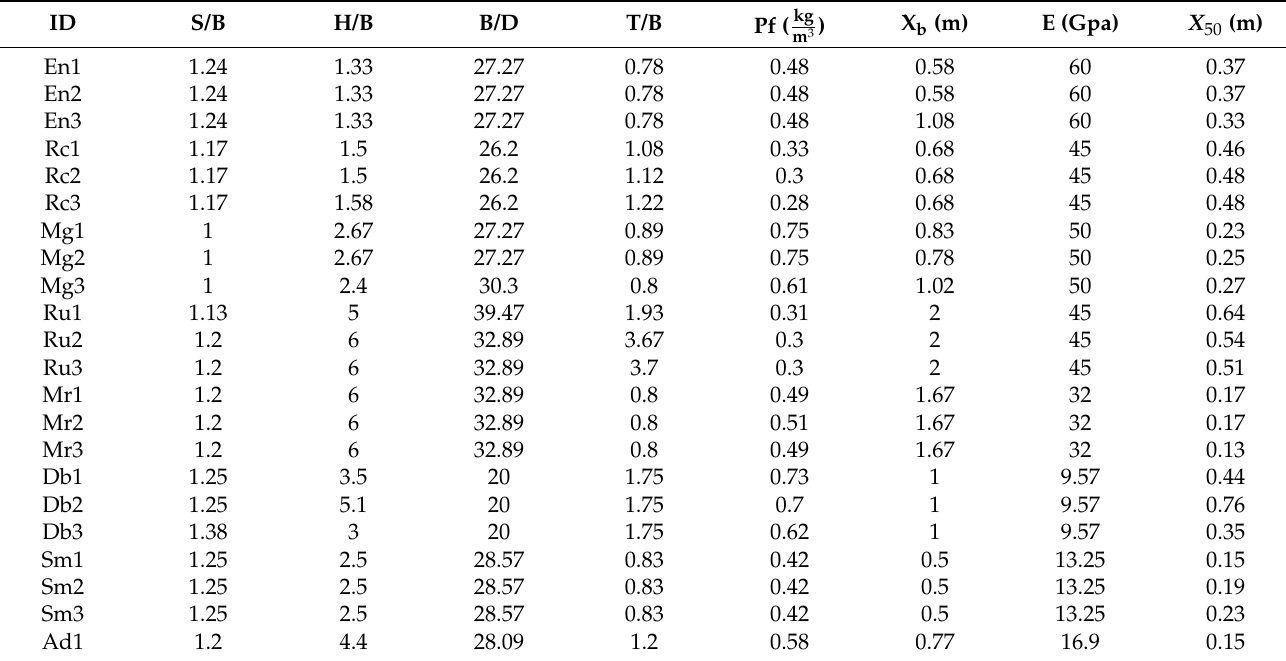
Table 1. Sample blast data